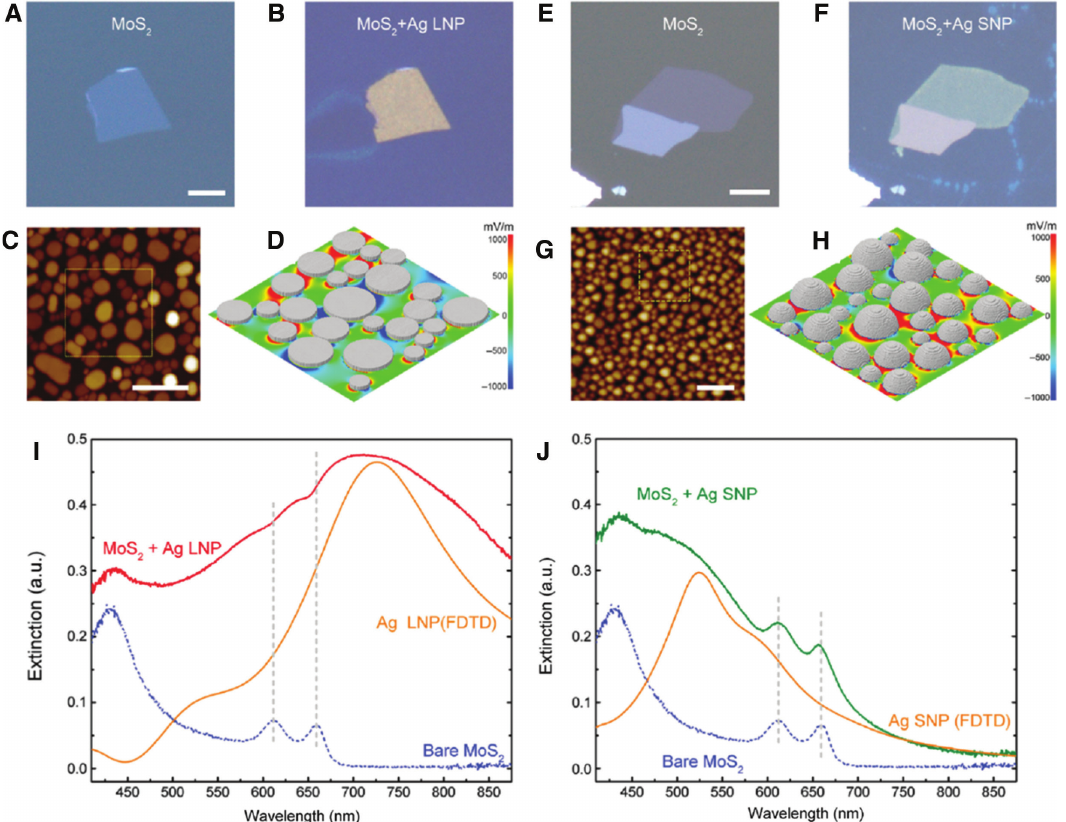
hybridized with Ag-NPs. Figure 6: Exciton-plasmon coupling in monolayer MoS 2 Optical micrographs of monolayer MoS on quartz without (A, E) and with (B, F) Ag-NPs. AFM micrographs (C, G) of monolayer MoS 2 2 with Ag-NPs and FDTD simulations (D, H) for localized field enhancement of indicated area in AFM. The Ag LNPs were simplified as 10-nm-thick nanodisks with various diameters, while Ag SNPs were simplified as semi-spheres with various diameters. The maximum field enhancements for Ag LNP and Ag SNP are 52 and 40 times, respectively. The scale bars are 5 μ m and 200 nm for the optical and AFM micrographs, respectively. (I, J) Experimental (red, green) and FDTD simulated (orange) extinction spectra for monolayer MoS with Ag LNP 2 and Ag SNP, respectively. Experimental extinction (dashed blue) of bare MoS are shown as references. As comparison, FDTD simulated 2 extinction were normalized to experimental extinction. Reprinted with permission Ref.